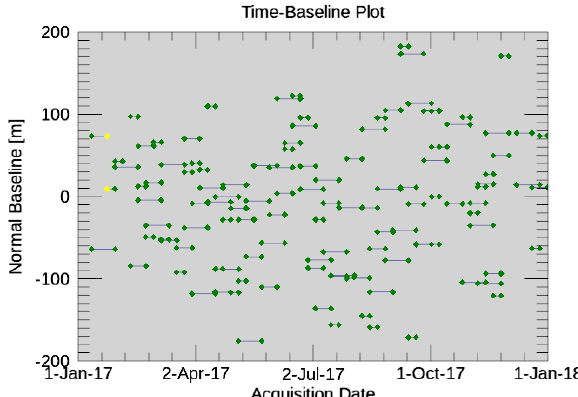
Figure 4. Normal and temporal baselines of connected image pairs in SBAS